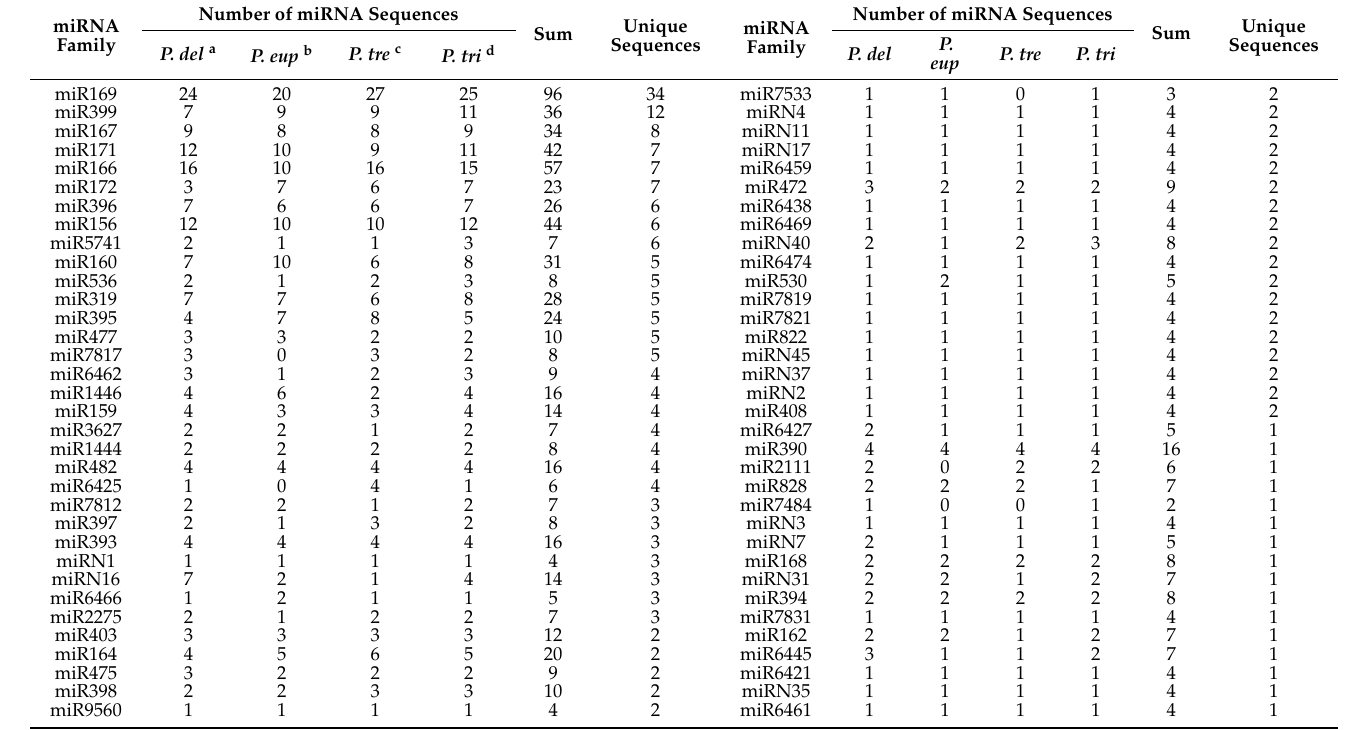
Table 1. Multiple unique sequences of miRNA in shared miRNA